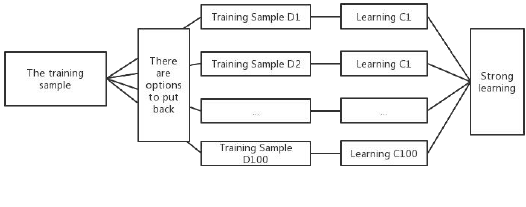
Figure 3 . Schematic diagram of random